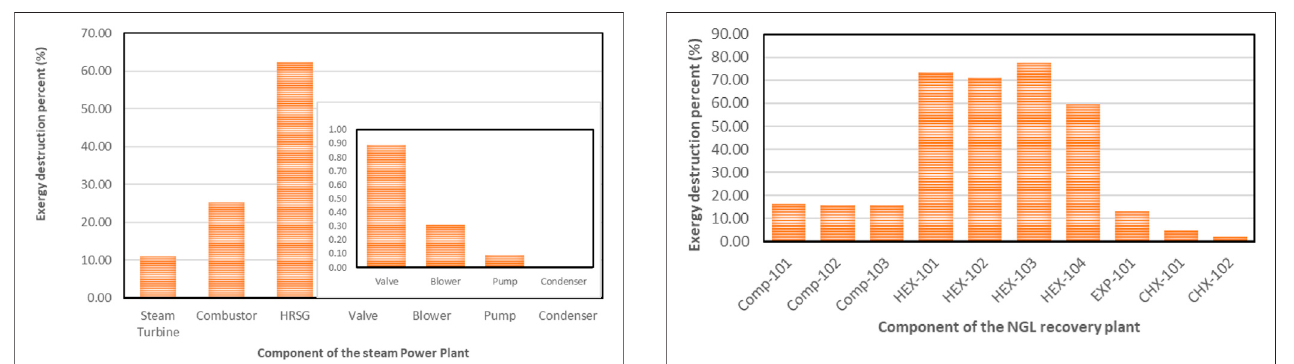
FIGURE12| Exergydestructionpercentforthecomponents intheNGL recovery